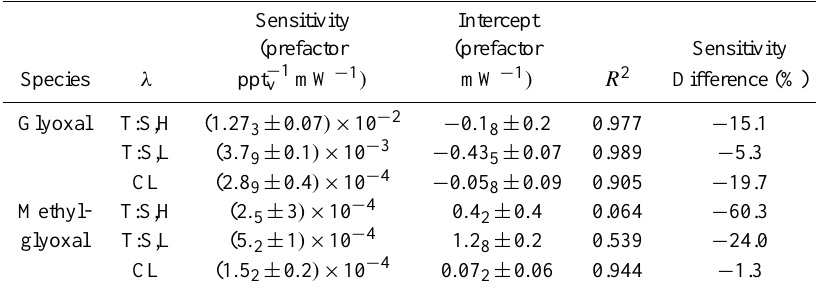
Table 3. Summary of the results from the six different calibrations with both glyoxal and methylglyoxal present inside the detection cell. The last column represents the relative percent difference in sensitivities as determined in a pure calibration versus in a mixture (100 × ( Sensitivity mixed − Sensitivity pure )/ Sensitivity pure ). During experiments at λ T : S , L , glyoxal ranged from 140 to 1000 pptv and methylglyoxal ranged from 130 to 5400pptv. During experiments at λ T : S , H , glyoxal ranged from 140 to 750 pptv and methylglyoxal ranged from 130